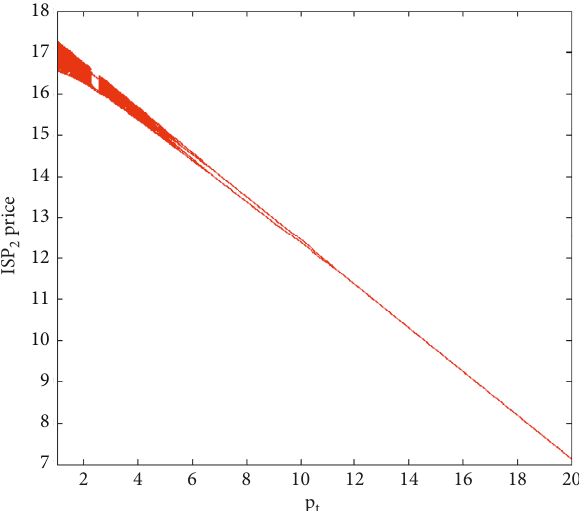
Figure 4: Bifurcation diagrams of p